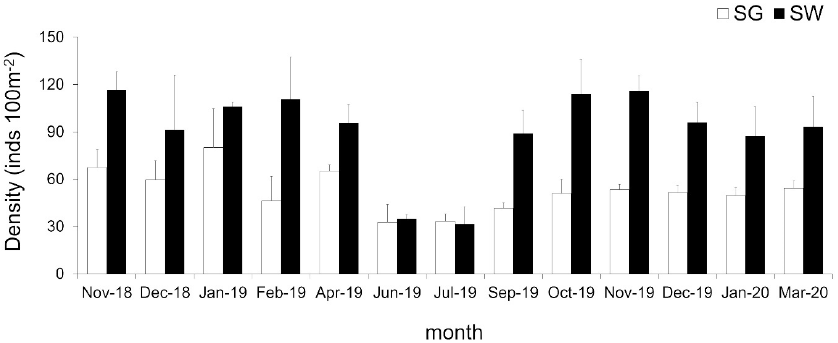
Figure 6. H. atra densities (mean ± SE) in the seagrass (SG) and seaweed (SW) habitats from No ‐ vember 2018 to March 2020.